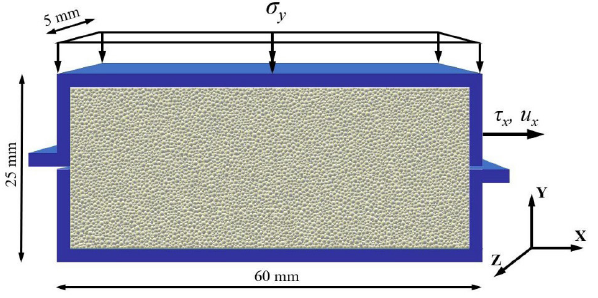
Figure 10: Model set-up for numerical simulations of direct shear test.